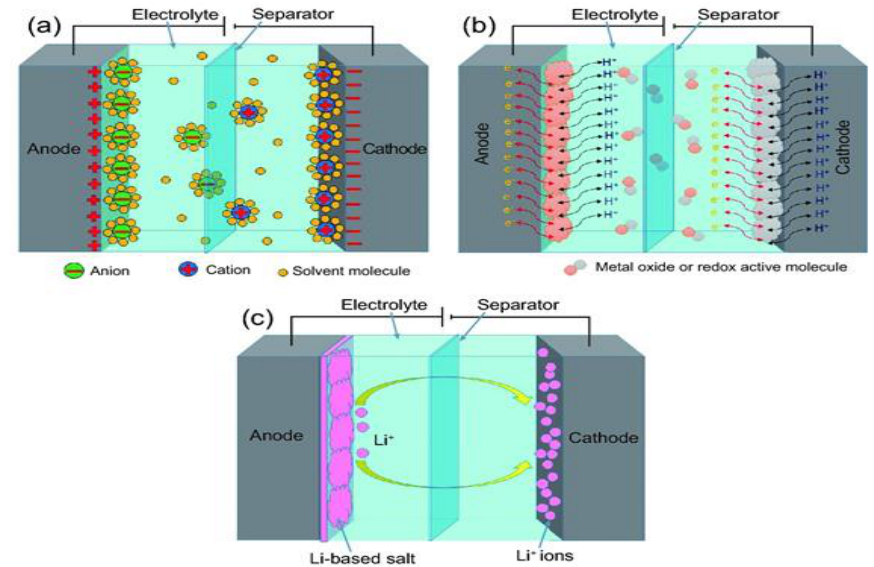
Figure 1. Schematic representation of ( a ) electrical double-layer capacitor (EDLC), ( b ) pseudocapacitor (PC) and ( c ) hybrid supercapacitor (HSC).